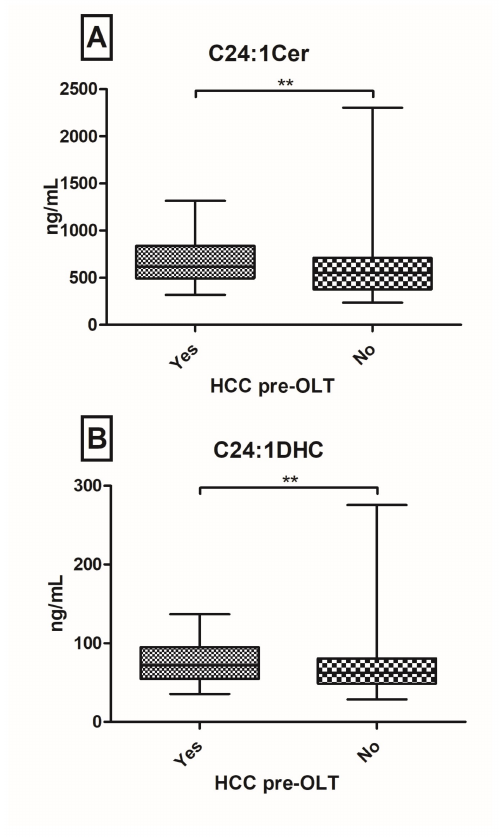
Figure 4. Serum ceramides (Cer) and dihydro-ceramides (DHC) in post-orthopic liver transplantation (OLT) patients with a history of hepatocellular carcinoma (HCC) pre-OLT. C24:1Cer ( A ) and C24:1DHC ( B ) are significantly up-regulated in patients with HCC pre-OLT, compared to no prior HCC (** p <